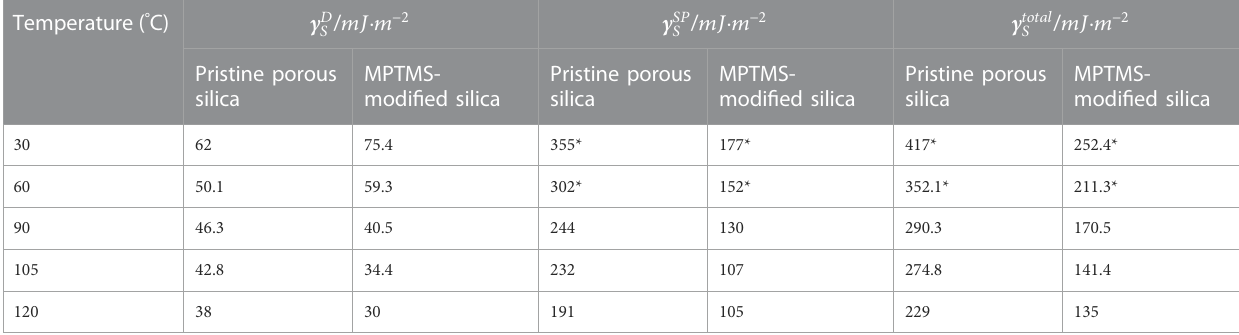
TABLE 1 Estimated values for the free surface energy γ total S and the dispersive γ D S and polar γ SP S components from 30 ° C to 120 ° C (*extrapolated values). Temperature ( °